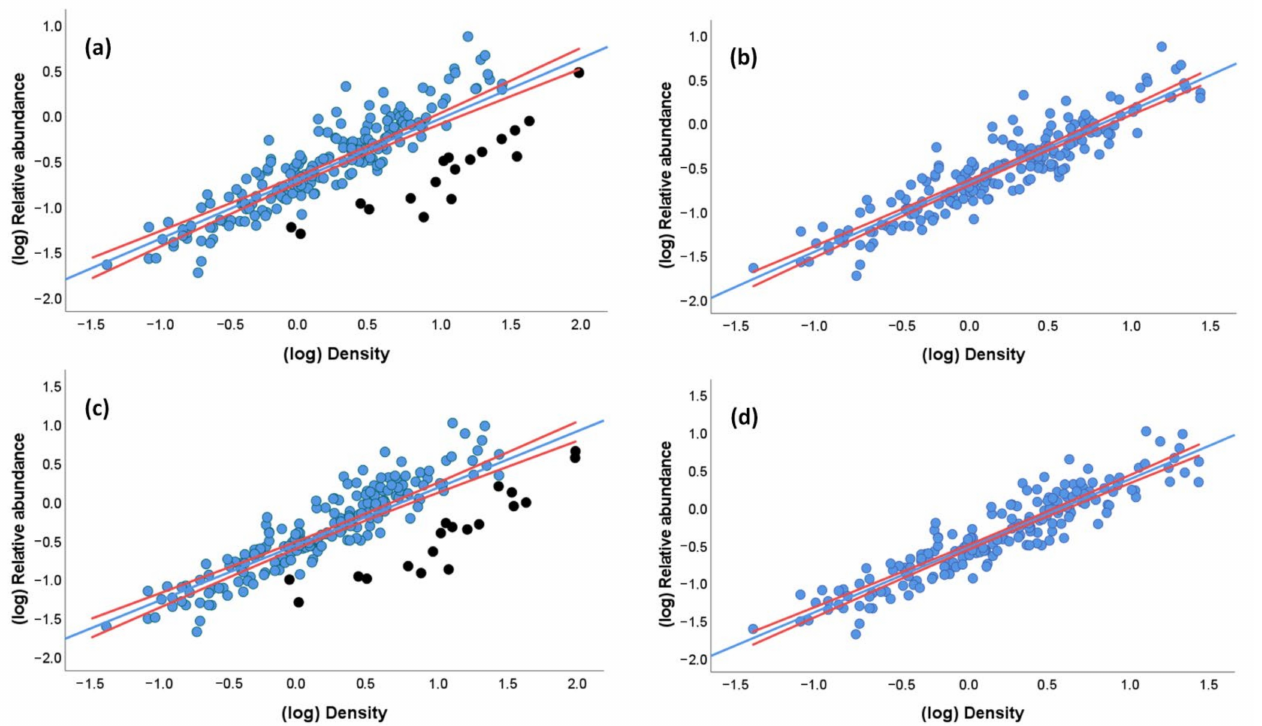
Figure 4. Relationship between ( a ) the relative abundance (individuals/km) and density (individuals/km 2 ) of parrots when including densities obtained from questionable probabilities of detection (black dots) and ( b ) excluding them, and ( c ) between the estimated relative abundance (i.e., (number of observed individuals + number of estimated heard individu- als)/km) and density (individuals/km 2 ) of parrots when including densities obtained from questionable probabilities of detection (black dots) and ( d ) excluding them. Densities were obtained through distance sampling modeling for 208 study cases with at least 10 visual encounters at distances < 500 m. Red lines represent the 95% CI for the regression lines.